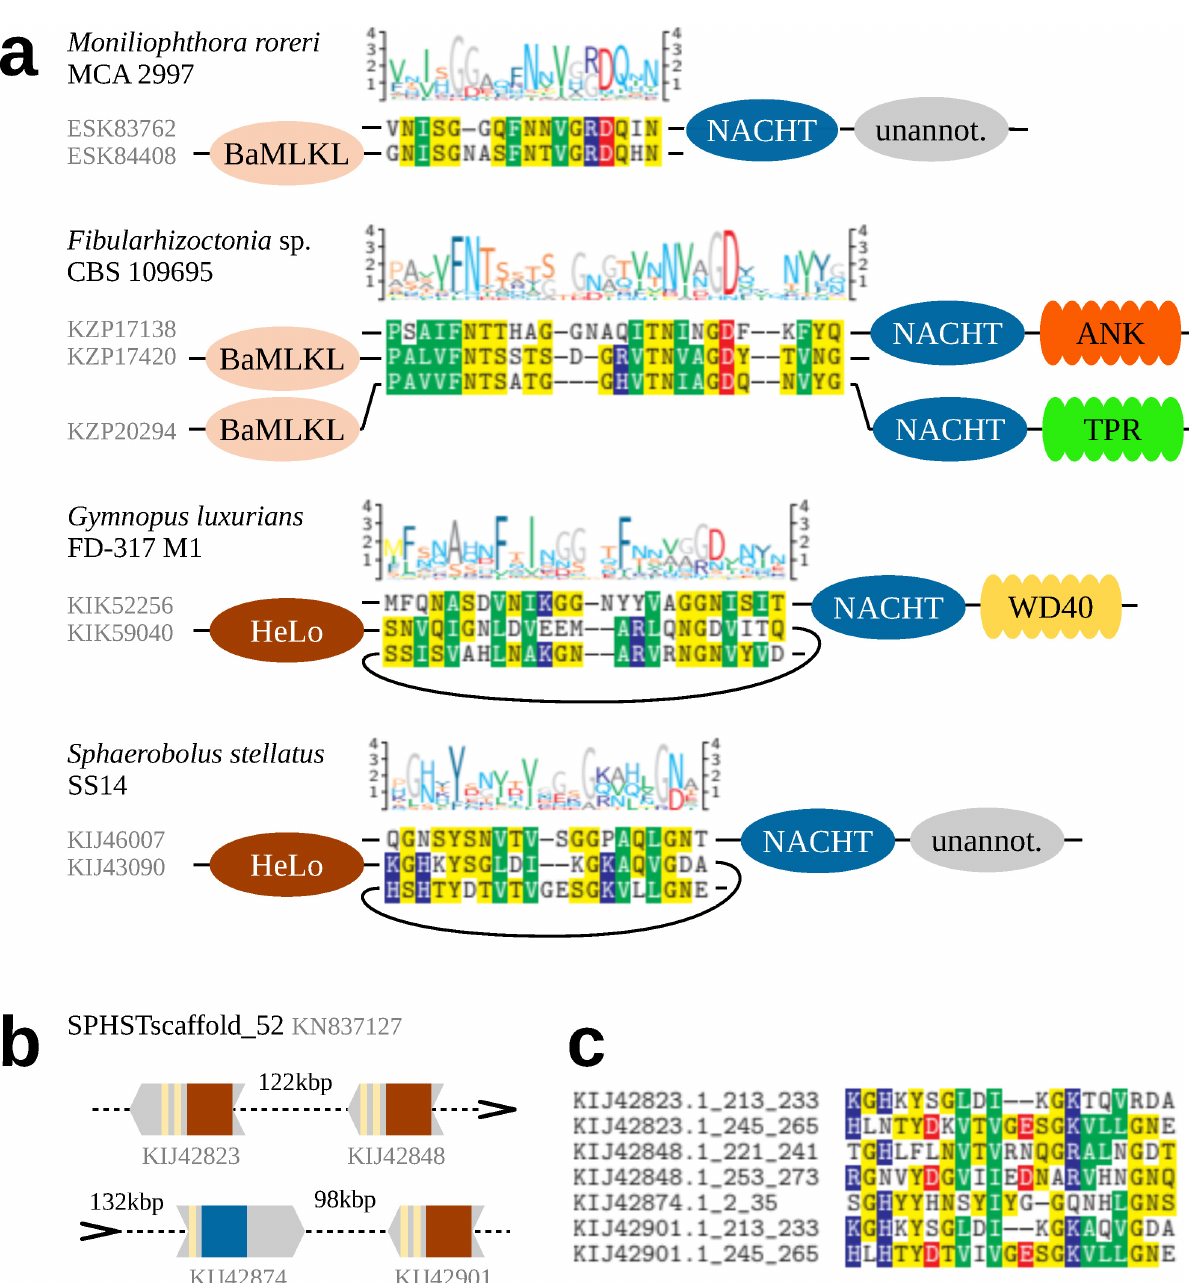
Fig 4. Potentially interacting amyloid-like motifs in Agaricomycetes. ( a ) Motif logos, sequence alignments and domain architectures of selected motif instances. ( b ) Schematic representation of a cluster of amyloid-like motifs in contig SPHSTscaffold_52 from genome assembly GCA_000827215.1 of Sphaerobolus stellatus SS14. ( c ) Multiple sequence alignment of motif instances in